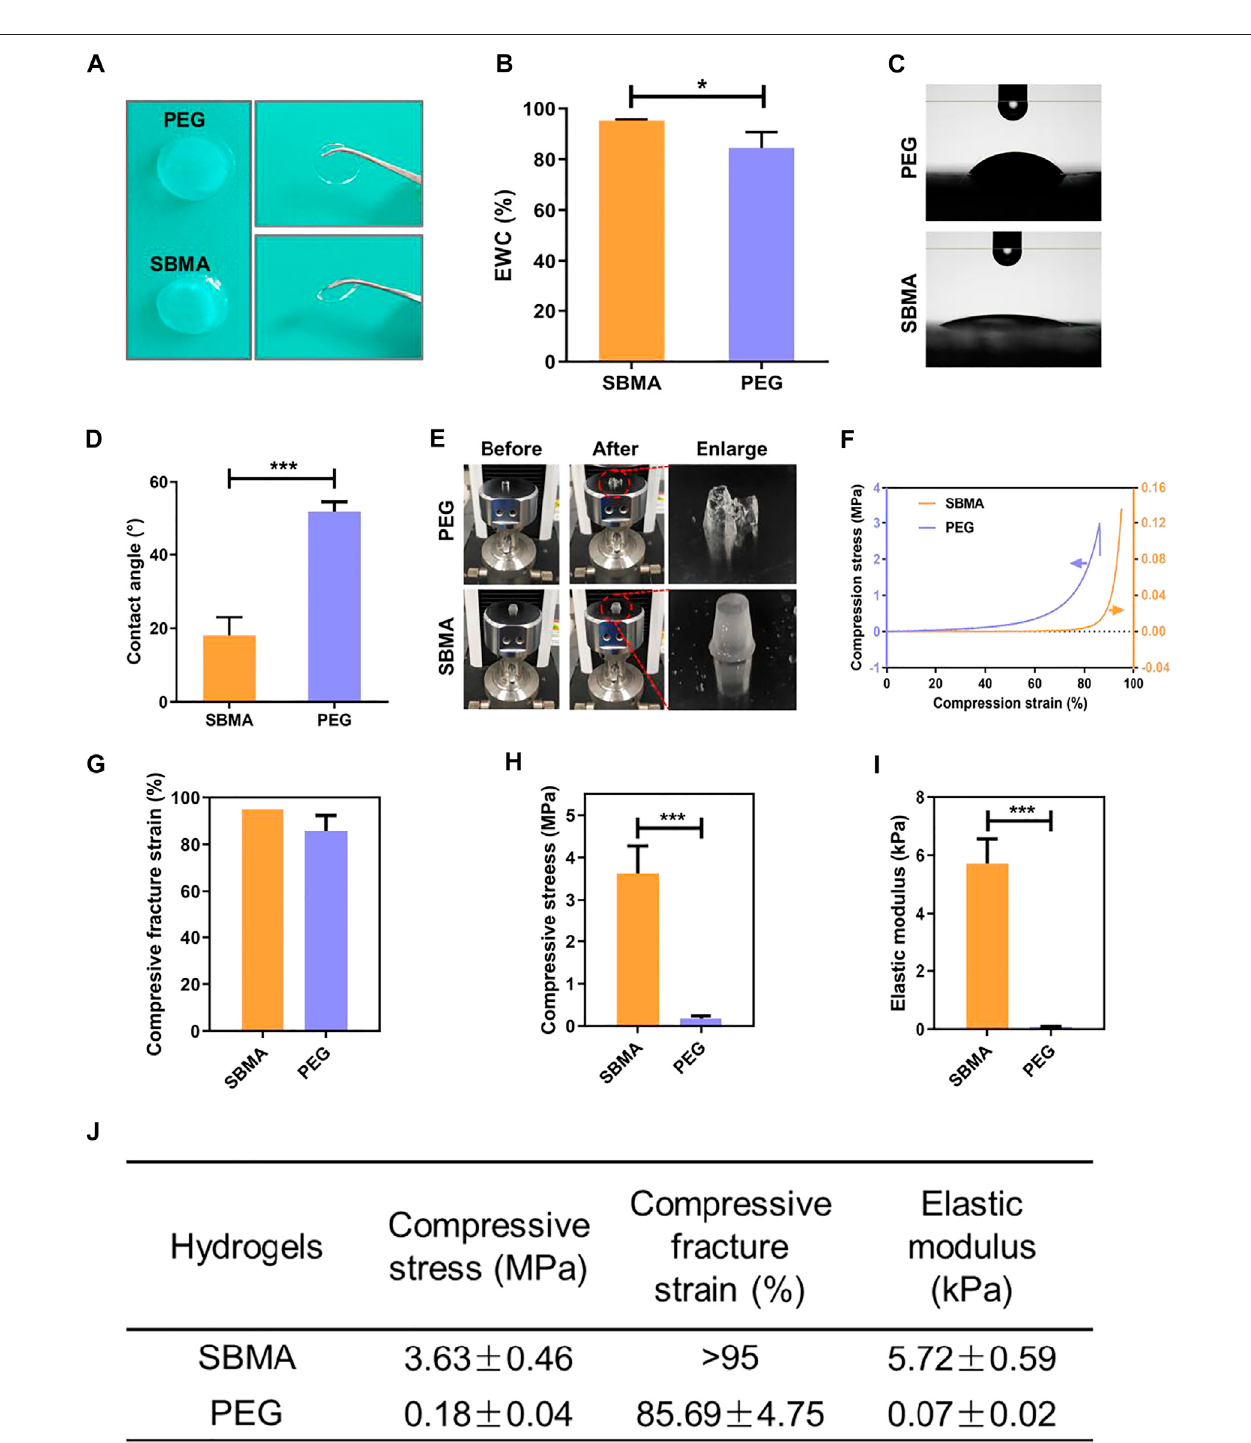
FIGURE 1 | Characterization of PEG and SBMA hydrogels. (A) Appearance ofPEG and SBMA hydrogels. (B) Equilibrium water content (EWC) of PEG and SBMA hydrogels incubated in normal saline. (C) Photographs of the contact angle measurements of PEG and SBMA hydrogels. (D) Bar diagram of quanti fi ed contact angle of PEG and SBMA hydrogels. (E) Representative photographs of PEG and SBMA hydrogels before and after loading compression force. (F) Compression stress – strain curves of PEG and SBMA hydrogels. (G) Bar diagram of the compressive fracture strain. (H) Bar diagram of the compressive stress. n (cid:1) 3. (I) Bar diagram of the elastic modulus. (J) Summary of the mechanical properties of PEG and SBMA hydrogels. Signi fi cant difference is indicated as * p < 0.05, *** p < 0.001, and n (cid:1) 3.